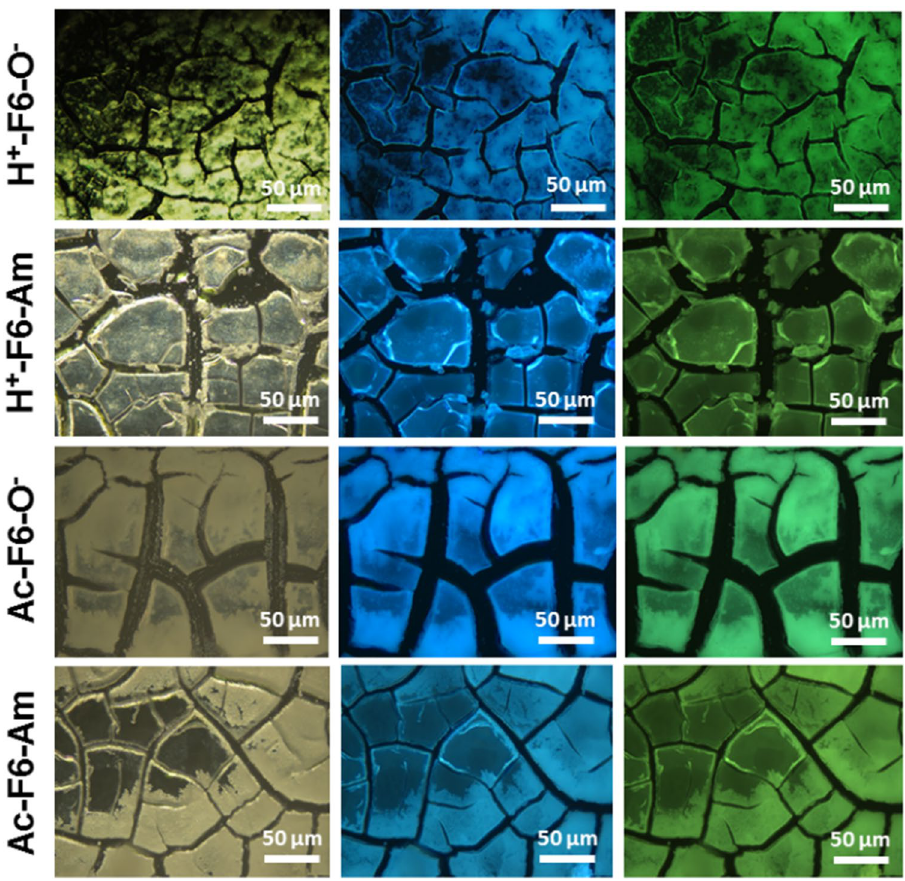
Figure 2. Optical microscopy images of all the F6 variants films, deposited on clean coverslip glass and air- dried at room temperature. From left to right: dark field images and fluorescence images excited in the spectral regions of DAPI (λ exc = 359 nm, λ em = 461 nm) and GFP (λ exc = 488 nm, λ em = 507